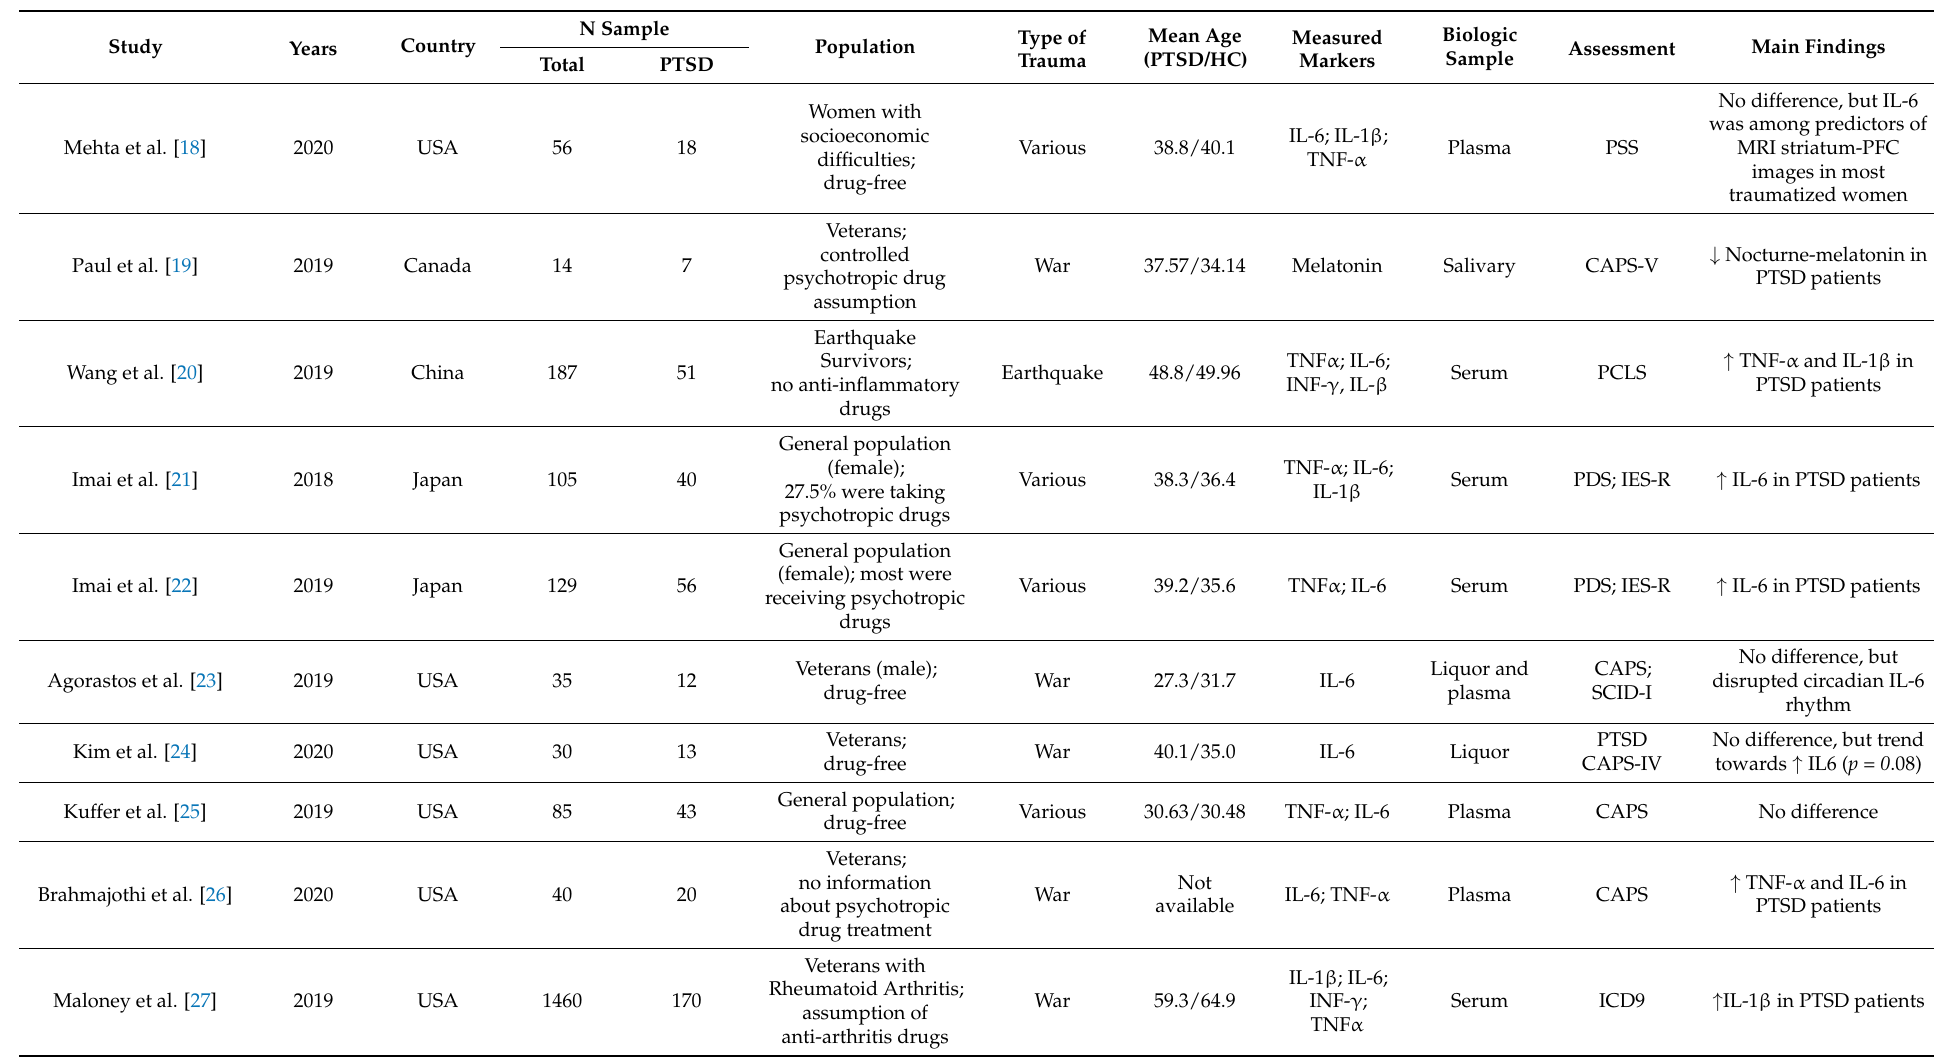
Table 1. Characteristics of the included